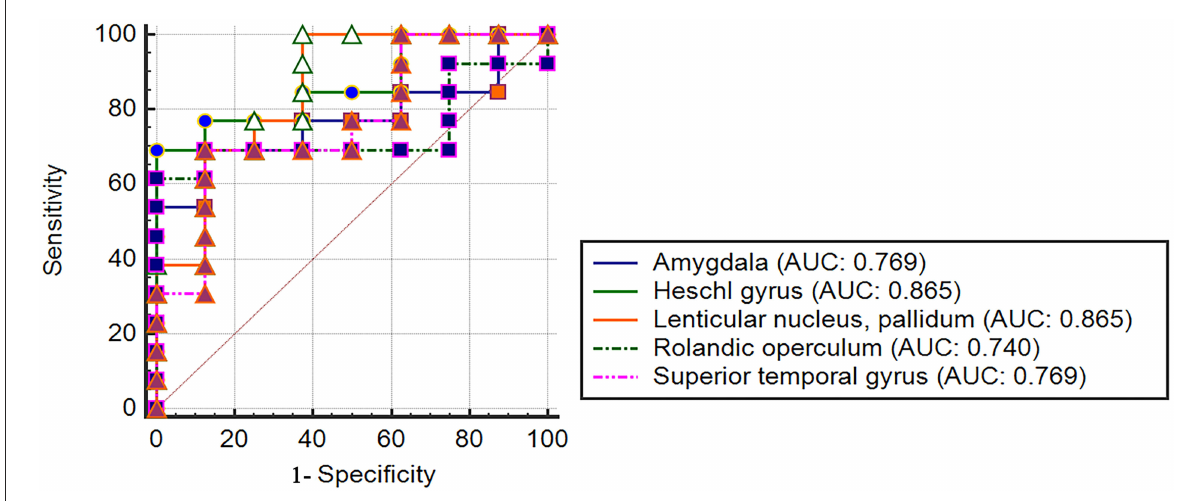
FIGURE6 Robustness analysis of prognosis prediction based on AAL